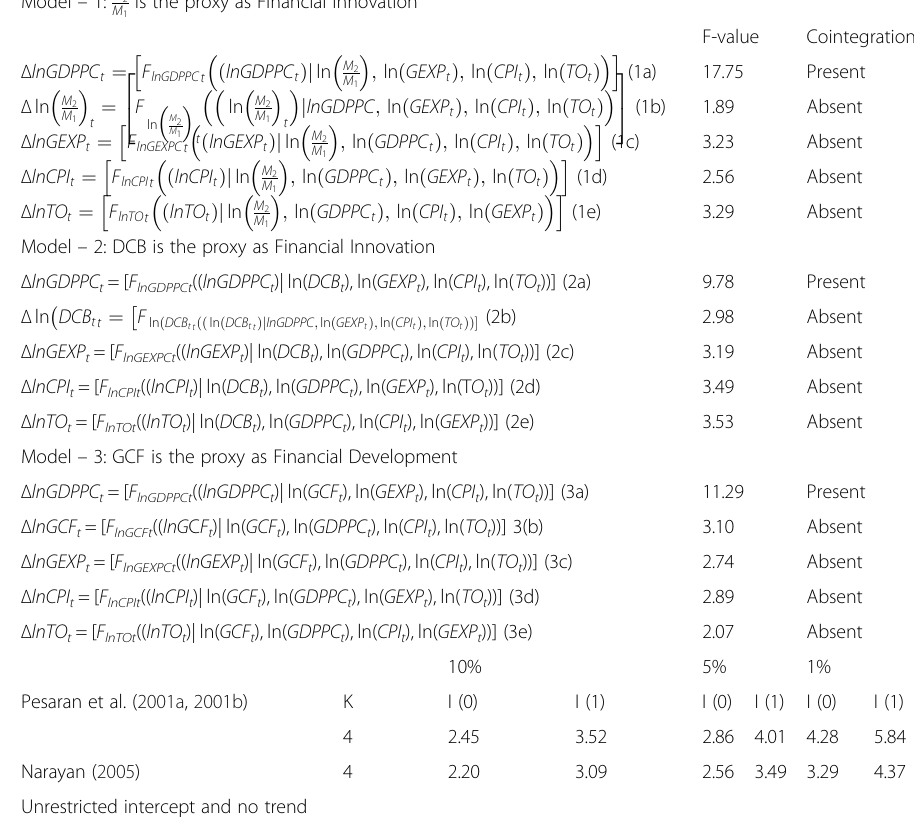
Table 5 Bound Testing Results Model – 1: M 2 M is the proxy as Financial 1